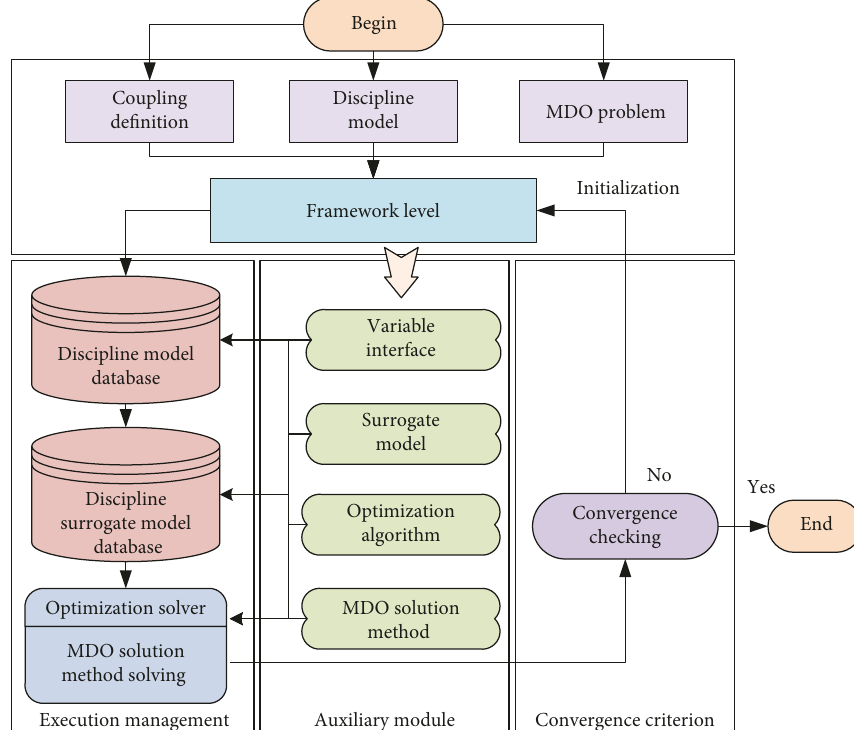
Figure 5: Flowchart of framework